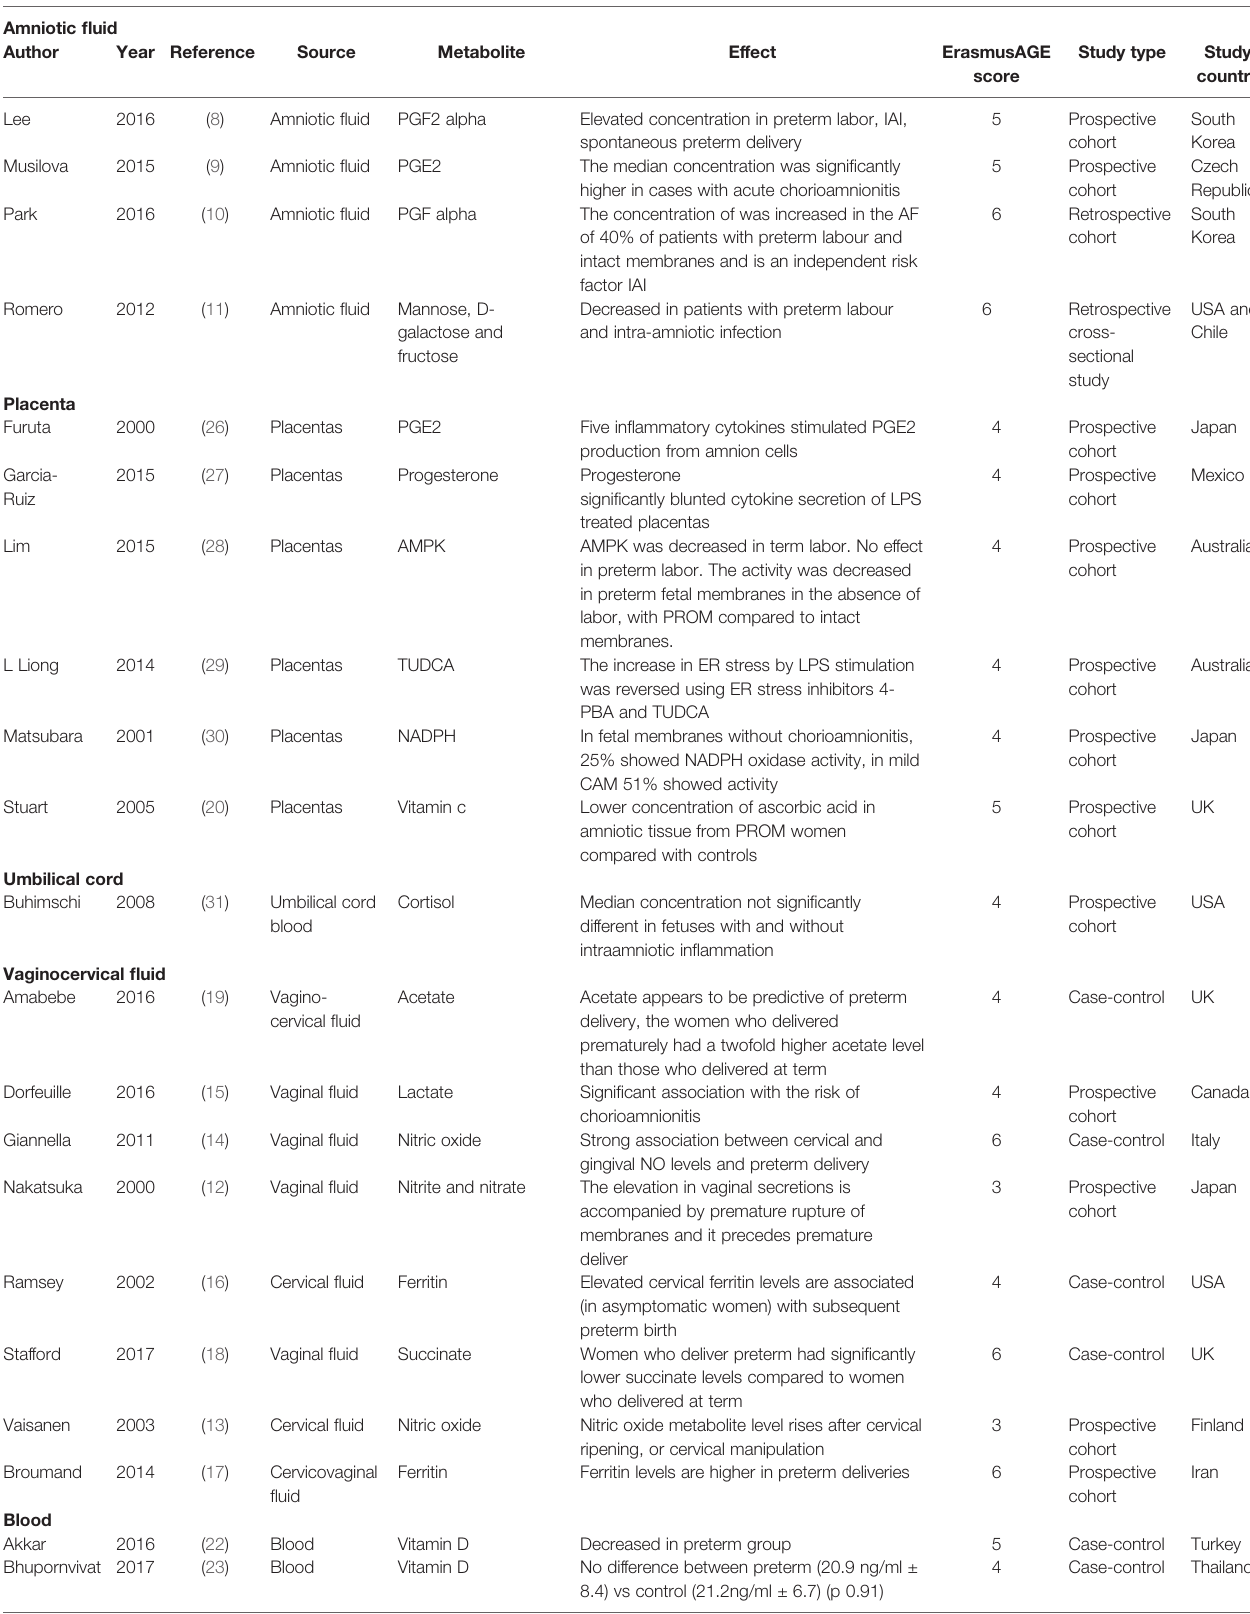
TABLE 2 | Study selection and